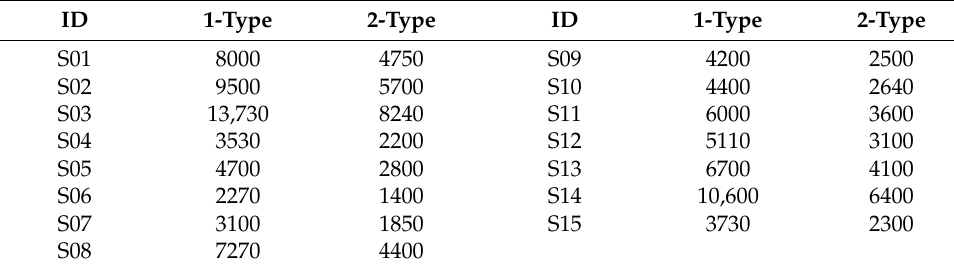
Table 6. Shelter capacity